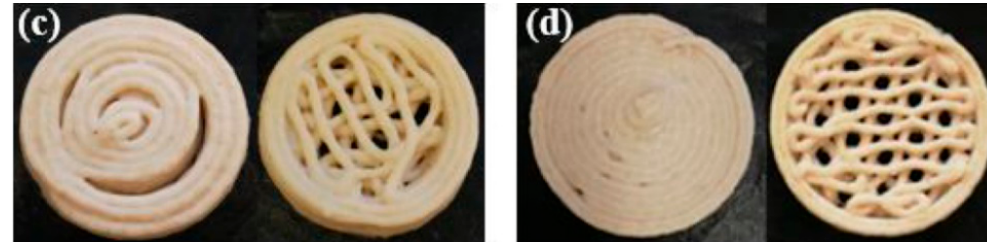
Figure 3. 3D printing dough formulations with different nozzle sizes of 1.6 mm ( left ) and 1.2 mm ( right ) containing probiotic bacteria [9].